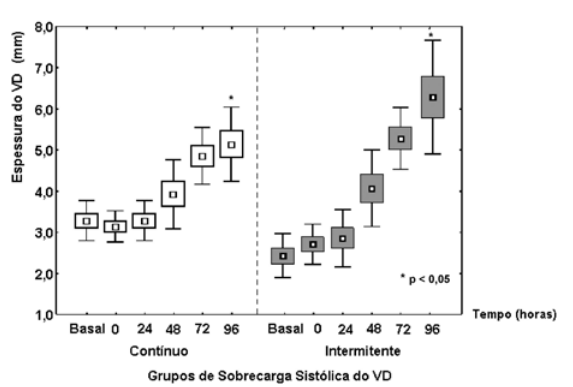
Fig. 3 - Medidas ecocardiográficas do Ventrículo Direito (VD). Espessura da parede livre do VD dos grupos submetidos à sobrecarga sistólica contínua e intermitente. (* p < 0,05)